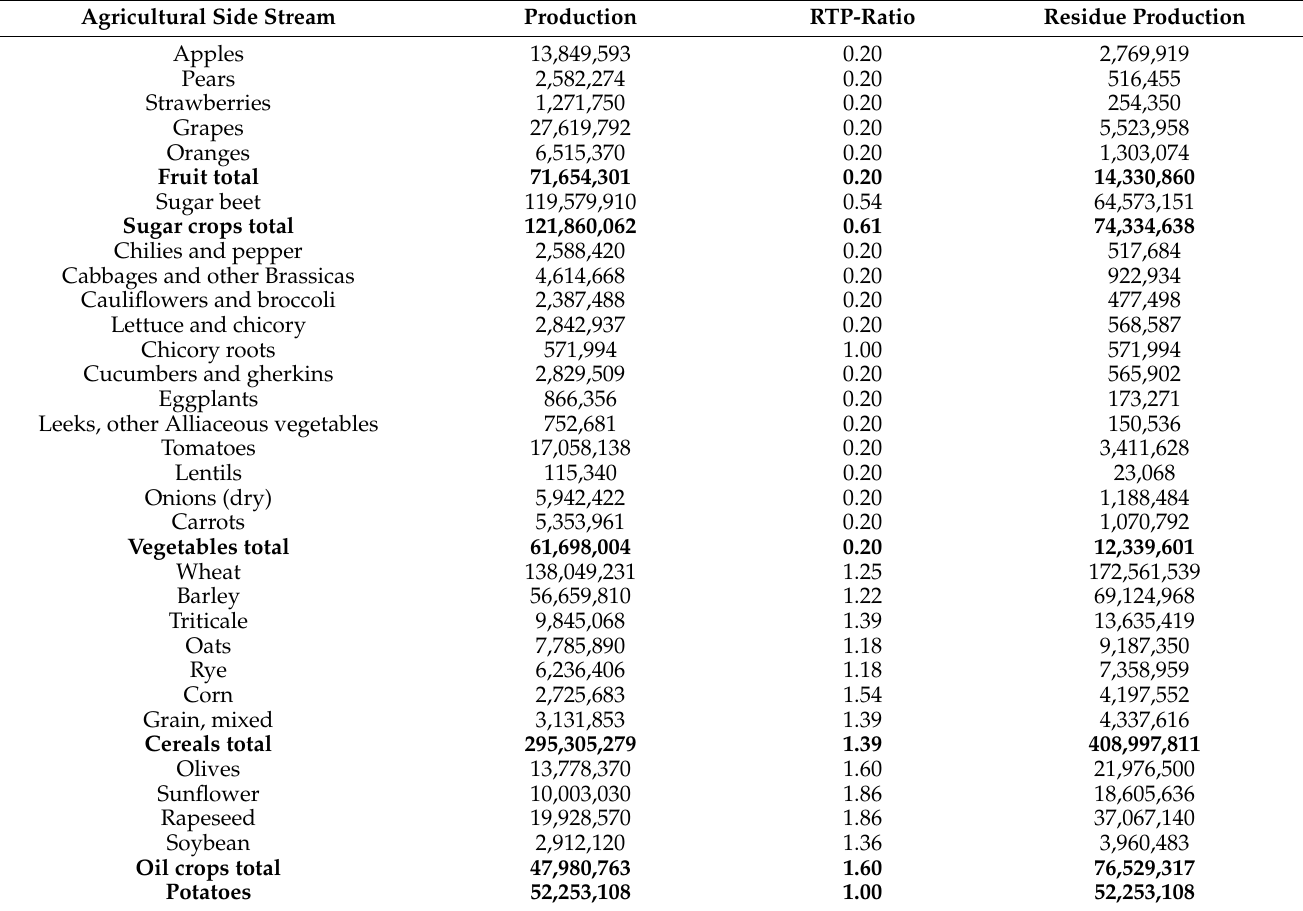
Table 3. Agricultural crop production data from FAOSTAT database [102] for 2018 and estimated availability of crop residues in tons for the EU(28). RTP-ratio is residue-to-product ratio, based on Ronzon et al. [101]. Agricultural Side Stream Production RTP-Ratio Residue